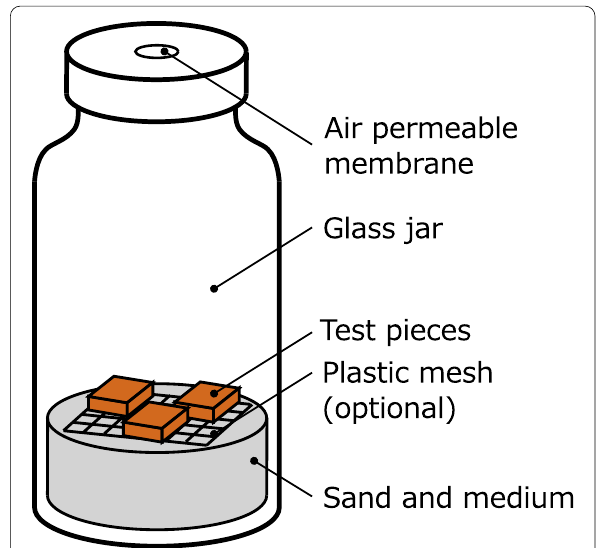
Fig. 1 Cultivation of the wood-decay